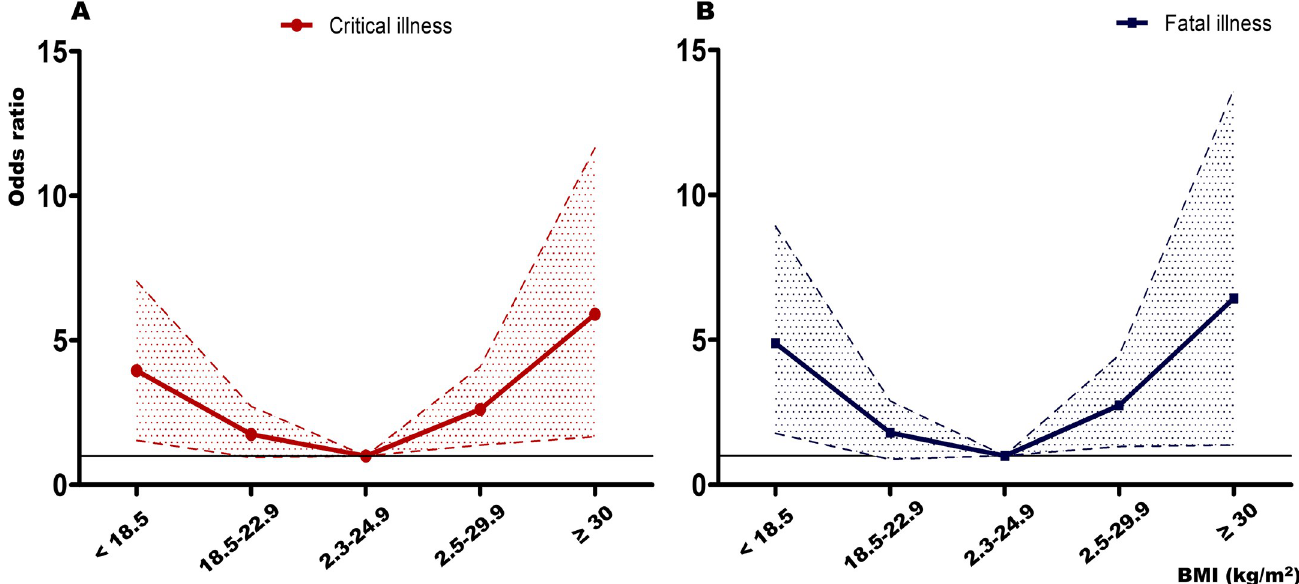
Fig 1. Odds ratios for critical and fatal illness according to body mass index. Odds ratios were adjusted for age, gender, and five comorbidities (diabetes mellitus, hypertension, chronic kidney disease, cancer, and dementia).